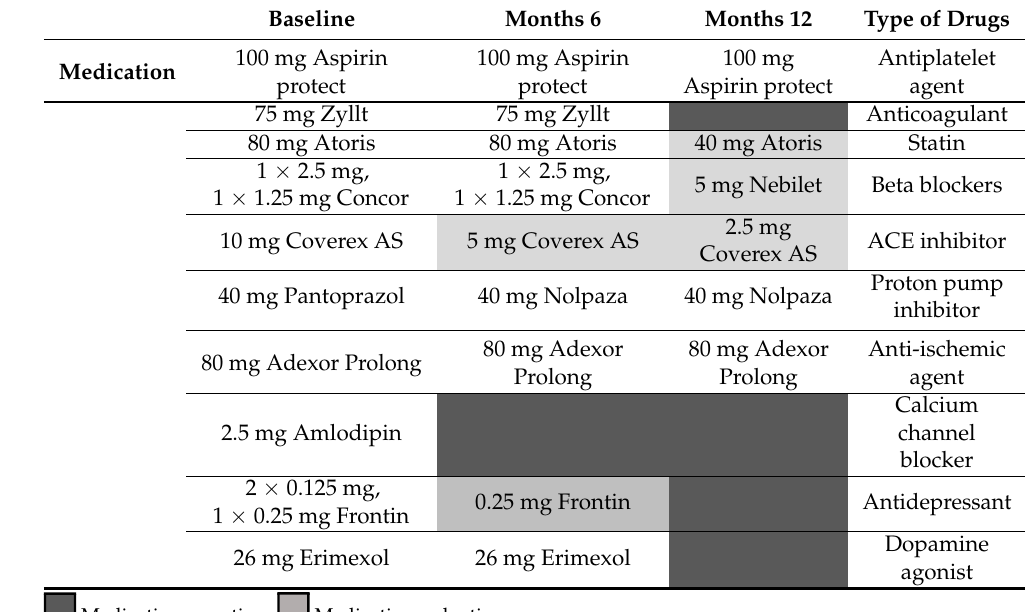
Table 2. Changes in